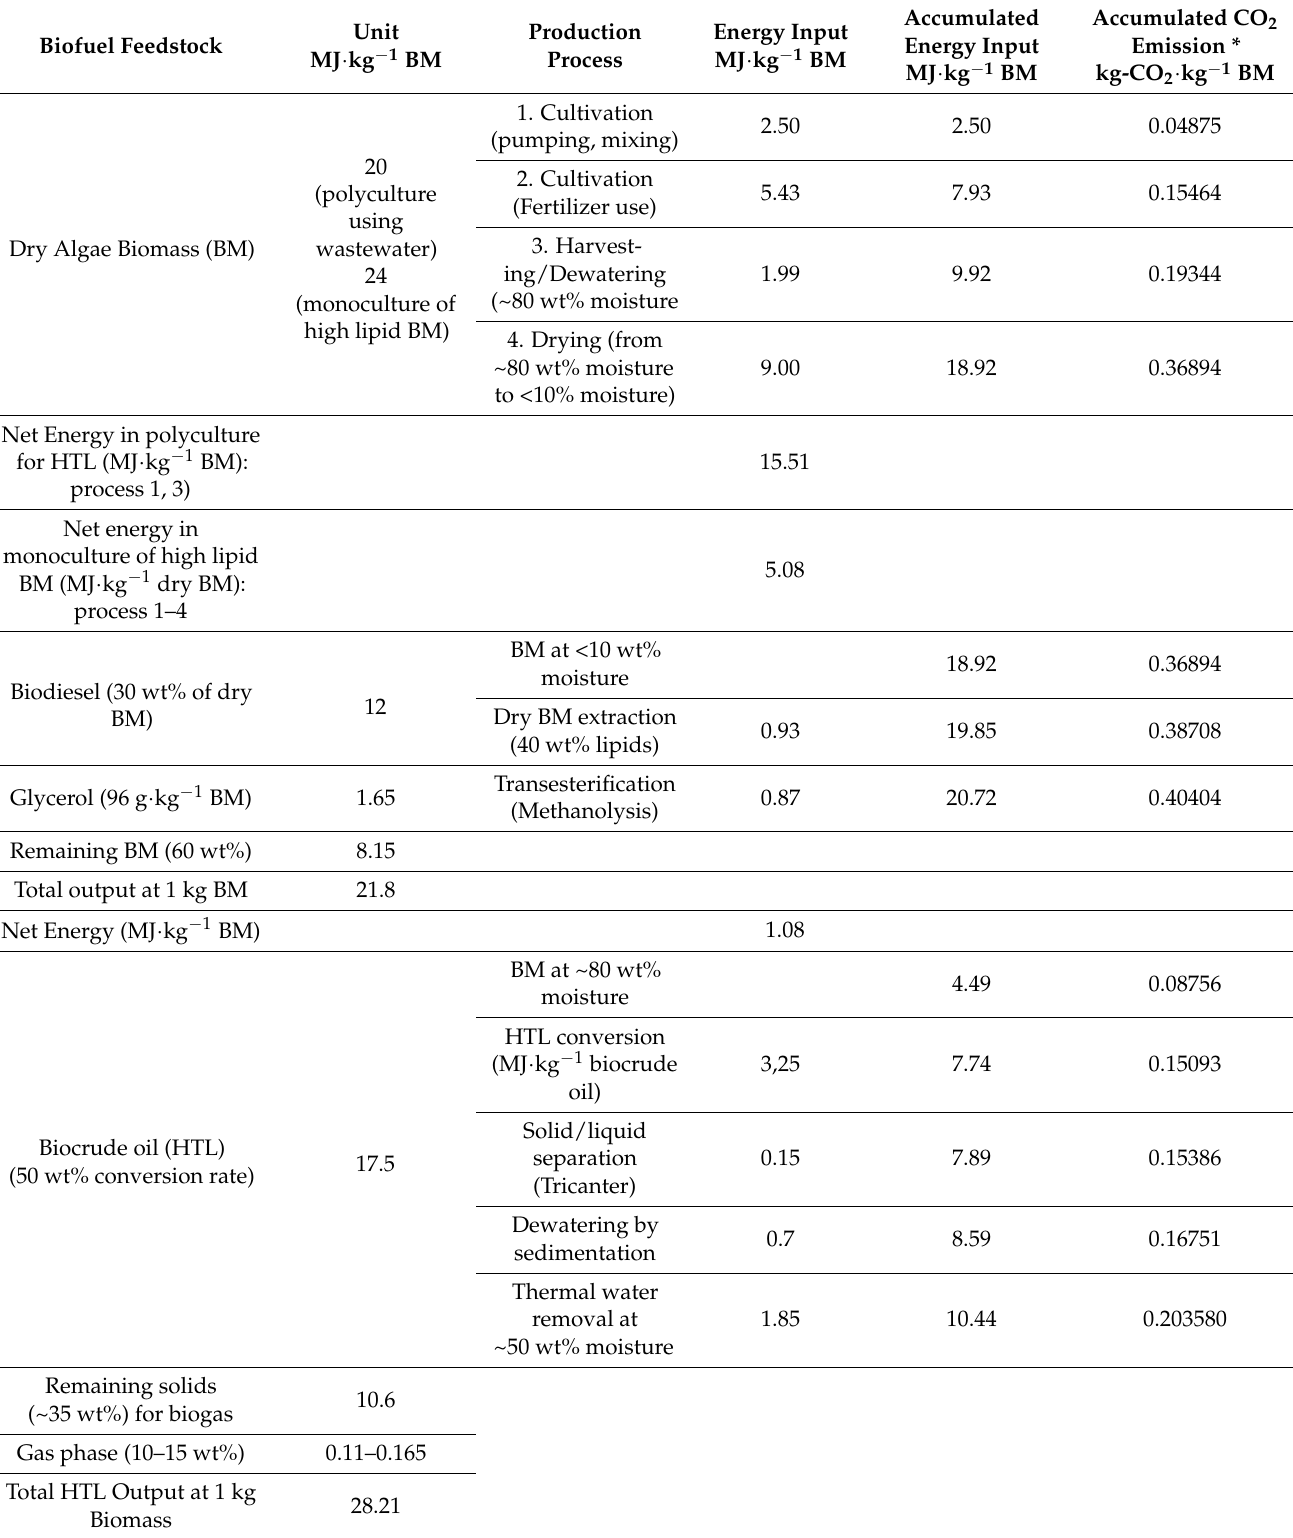
Table 7. Comparison of energy balance and CO 2 emission between conventional biodiesel production and biocrude oil production, which was prepared from the literature shown in Table 6 and